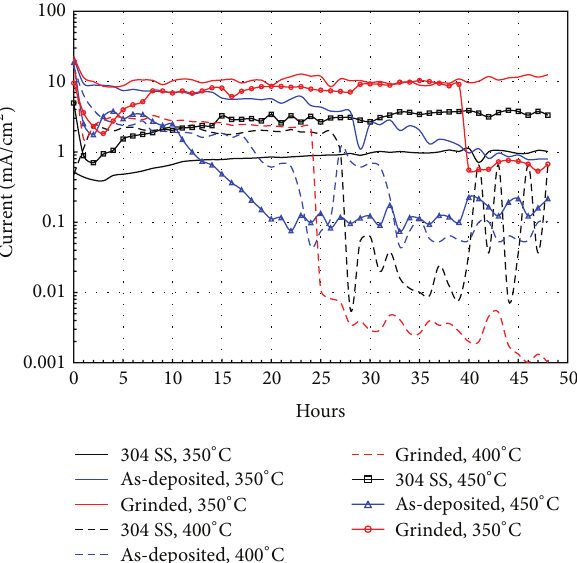
) plots of different materials at corr